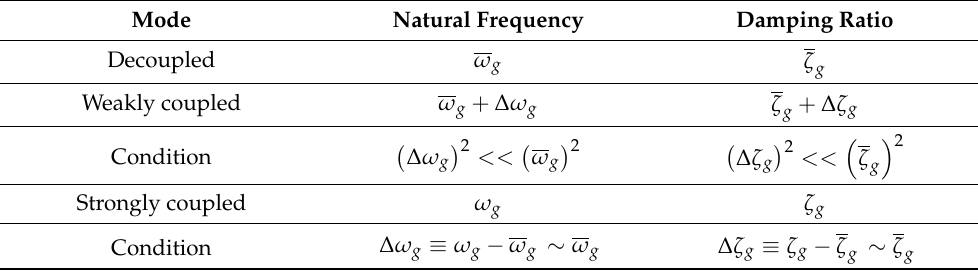
Table 2. Comparison of coupled, weakly and strongly coupled modes. Mode Natural Frequency Damping